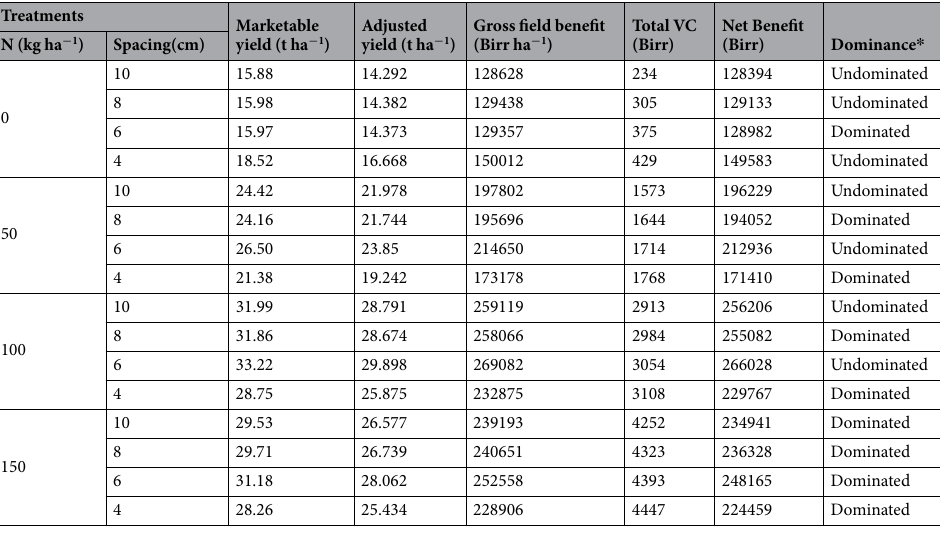
Table 4. Partial budget analysis. * When the new technology surpassed the conventional practice, it is said to be Undominated. When the new technology yields lower benefit then the technology is indicated as